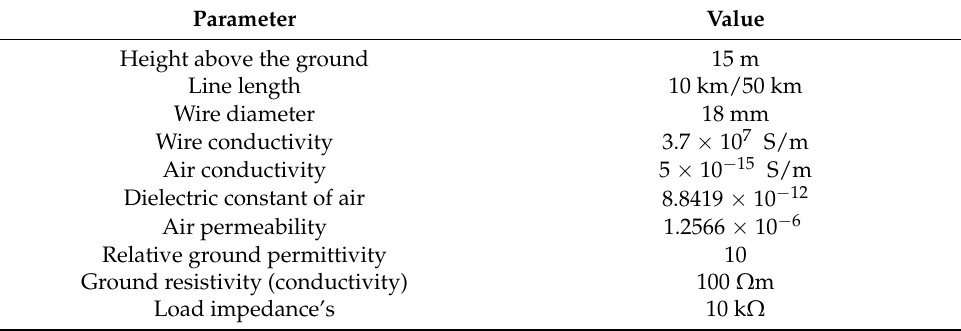
Figure 4. Fault-generated transients recorded at x = 0 due to a fault at x f = 8 km. Table 1. Transmission line